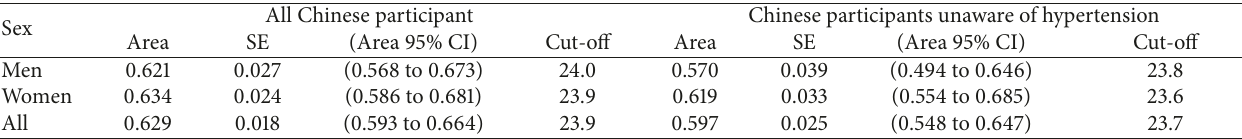
Table 4: Areas (with 95% confidence intervals) under the receiver operating curves and cut-off values for body mass index, for identifying hypertension in the whole Chinese cohort and in Chinese participants unaware of